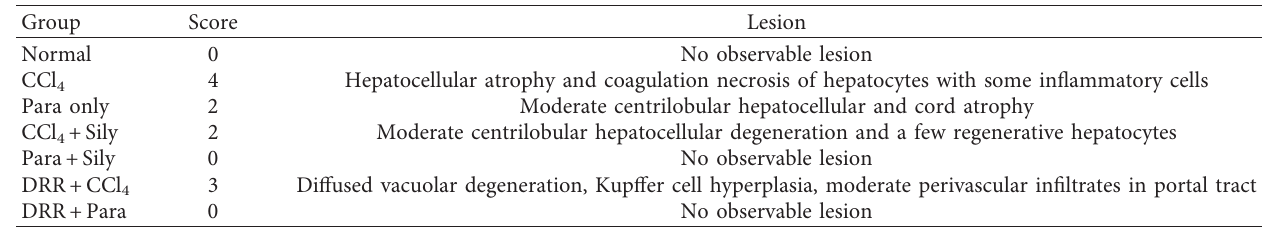
Figure 3: Photomicrographs showing liver of rats. (a) Normal-the hepatocytes are normal morphologically and arranged in cords around blood vessels except that the limiting plate appears shrunken, (b) CCl 4 only-centrilobular coagulation necrosis of hepatocytes, (c) CCl 4 +Sily-moderate centrilobular hepatocellular vascular degeneration, restricted more to the zone 3 hepatocytes and a few regenerative hepatocytes, (d) CCl 4 + DRR-diffuse hepatocellular atrophy, spotty hepatocellular necrosis, Kupffer cell hyperplasia, and moderate perivascular infiltrates in the portal tract, (e) Para only: Moderate centrilobular hepatocellular and cord atrophy, (f) Para+Sily: normal (no observable lesion), and (g) Para+DRR: LIVER- normal (no observable lesion). Table 4: Scoring of